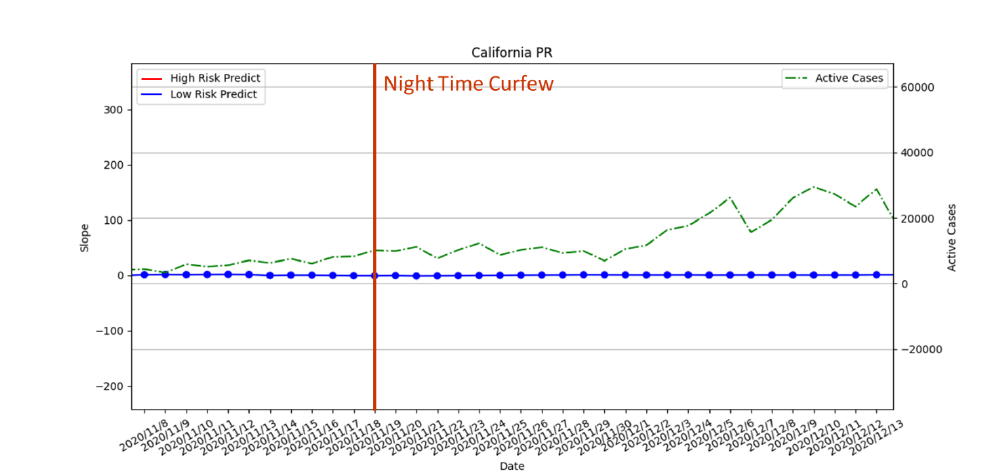
Figure 19. The result of risk analysis with PR for curfew policy in California.